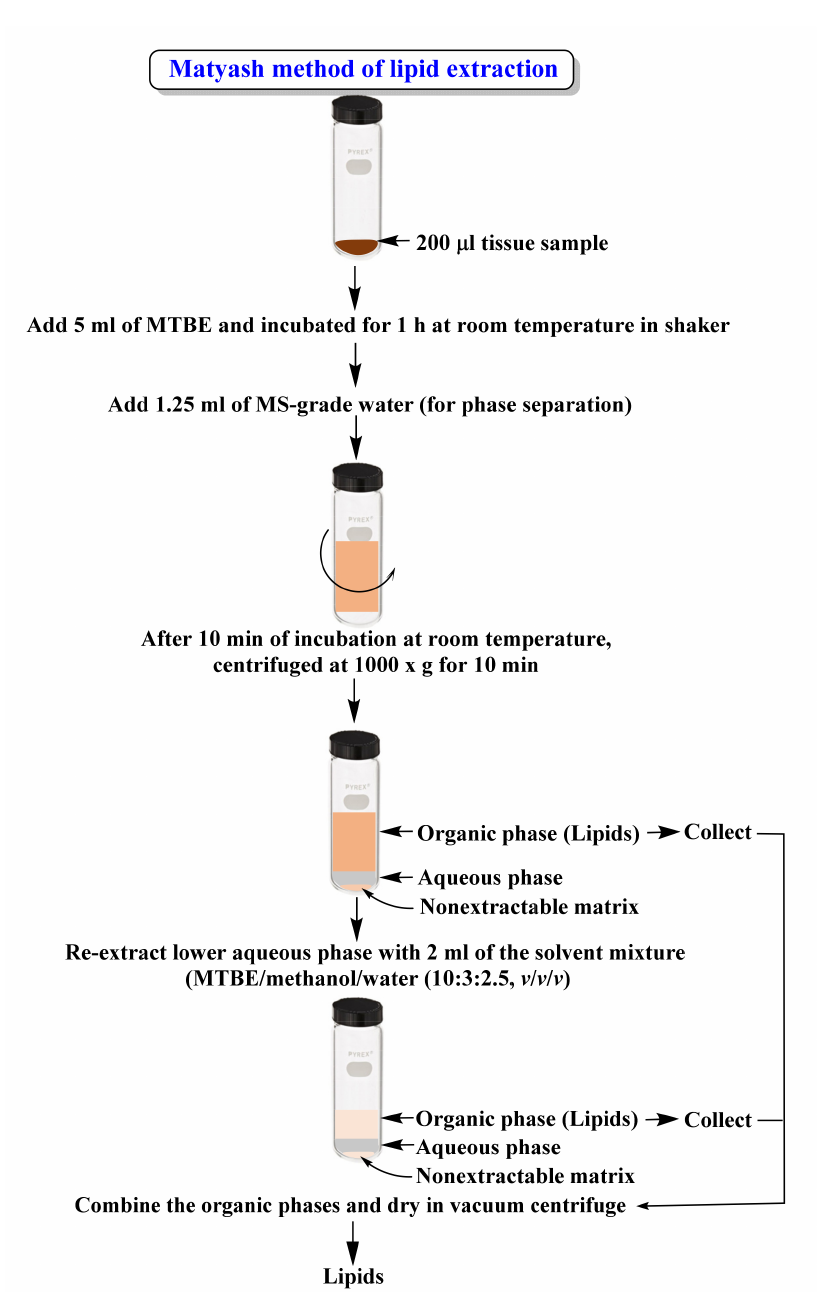
Figure 2. Illustrations showing the Matyash [12] method of lipid extraction. Targeted lipidomics mainly focuses on the analysis of specific lipid classes. The chemi- cal structure and polarity of the lipid species of interest drive the selection of the extraction method. Liquid-liquid extraction (LLE) methods using non-polar solvents such as n-hexane or toluene are commonly used to extract highly hydrophobic lipid molecules such as TAGs, diacylglycerols (DAGs), esters of fatty acid, and cholesterol [92]. Chloroform/methanol- based or MTBE-based LLE extraction methods are generally used for intermediate and highly polar lipids such as GPLs and sphingolipids. However, optimizing various pa- rameters such as solvent mixtures and their ratios and acidic /basic extraction conditions are required to avoid recovery differences across lipid classes. For example, the use of mild acidic conditions during LLE improves the recovery of phospholipids such as phos- phatidic acid, phosphatidylserine, and phosphatidylinositol [93,94]. Although the above methods can efficiently recovery lipid species of interest, lipid oxidation due to